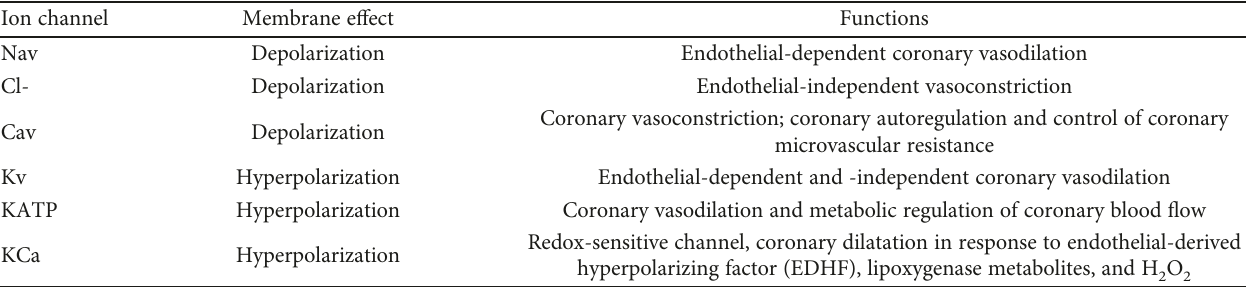
Figure 5: Schematic representation of ion movements through coronary ion channels. Table 1: Coronary ion channels and their physiological role in the regulation of coronary vascular